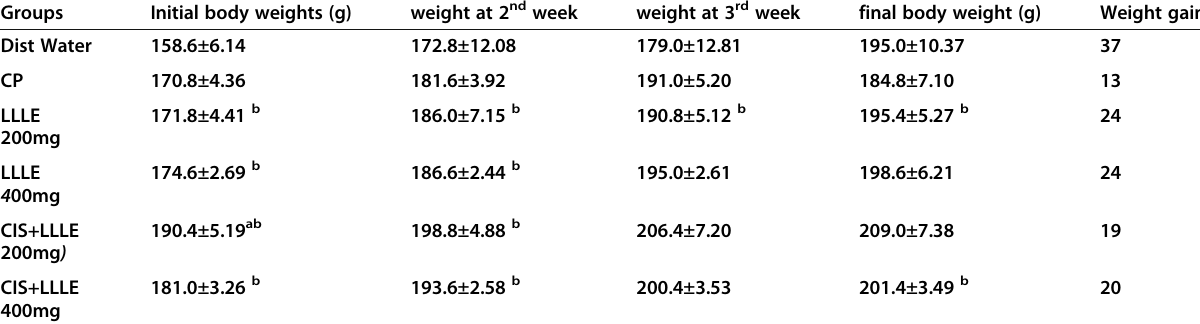
Table 1 Protective effect of oral administration of LLLE for 26 days on body weight of Male Wistar rats treated with CP